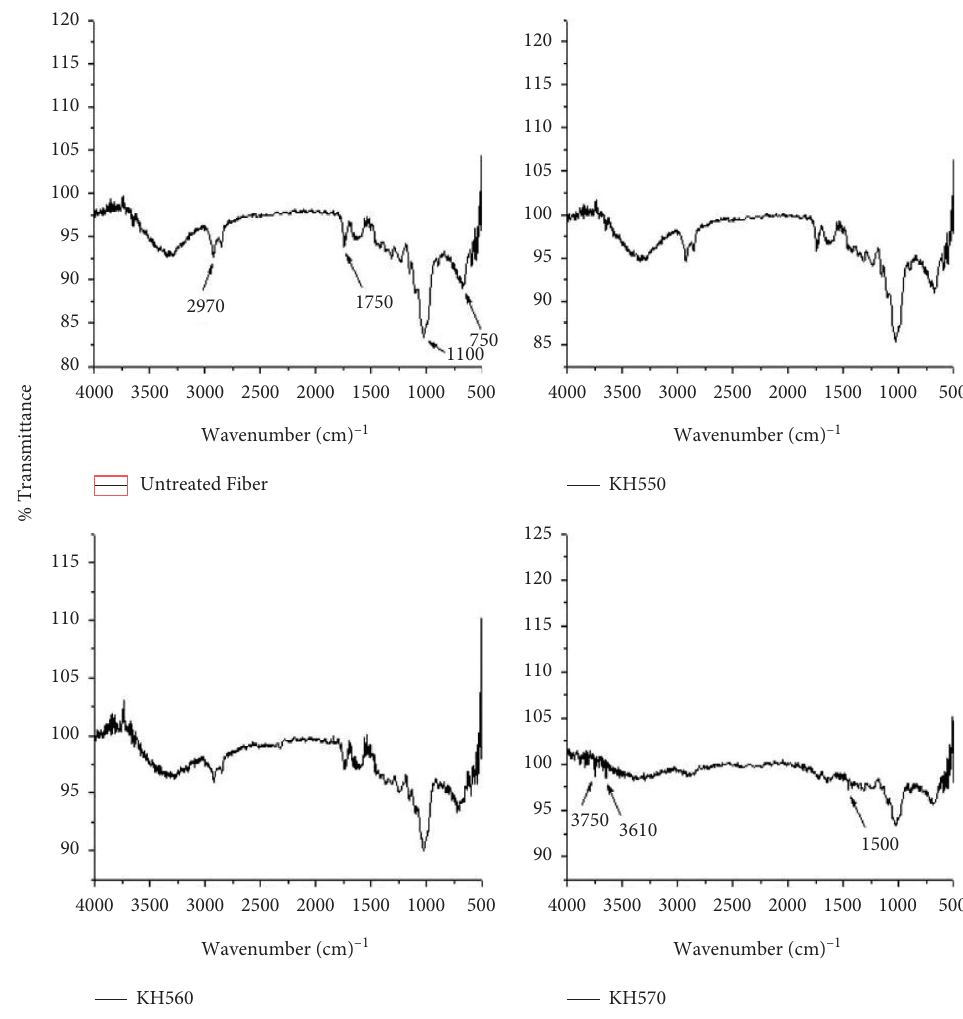
Figure 4: FTIR spectrum apex of unmodifed and silane modifed inforescence fbrils. Table 1: Mechanical properties of untreated and silane-modifed inforescence/glass fber-reinforced hybrid composites. Sl.